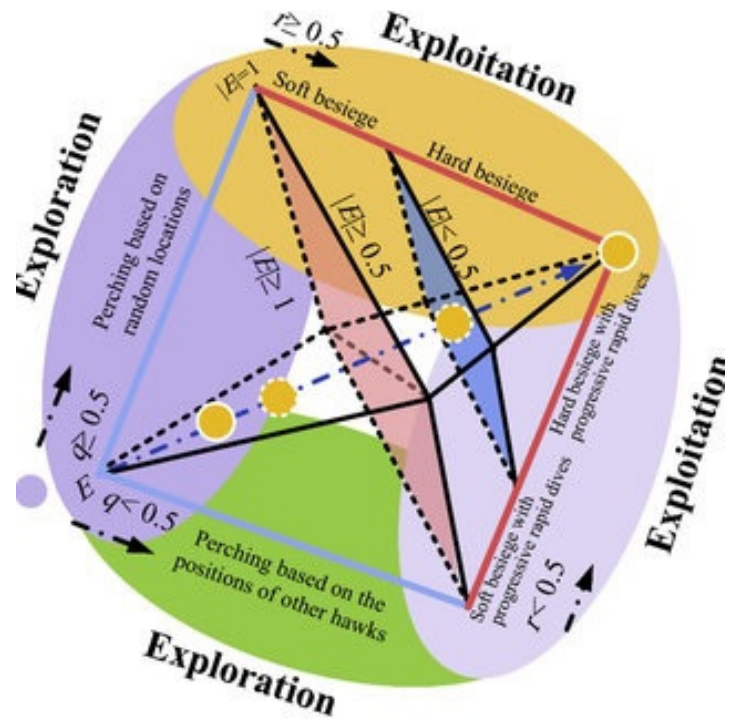
Figure 4. Various phases involved in HHO